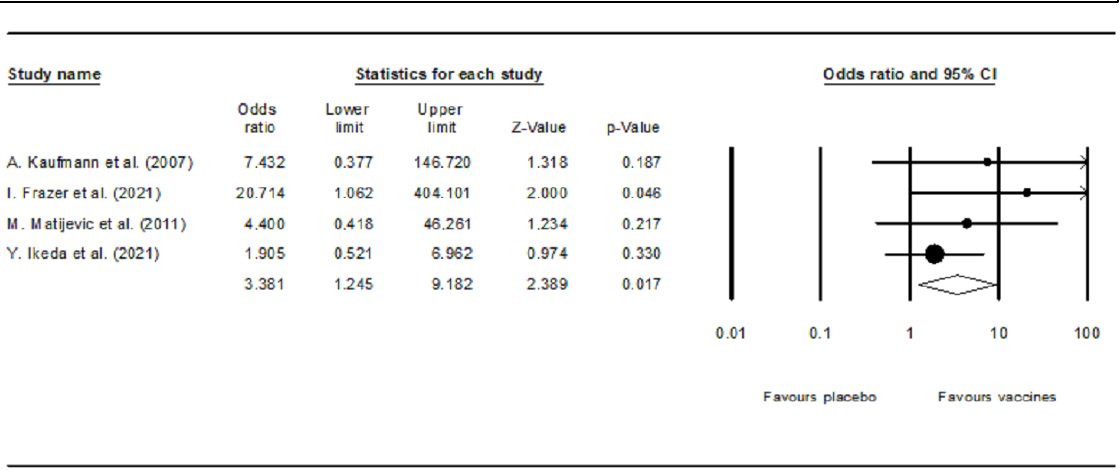
Table 2. Adjusted values of the pooled effect sizes for the absence of publication bias (Duval and Tweedie’s Trim and Fill).